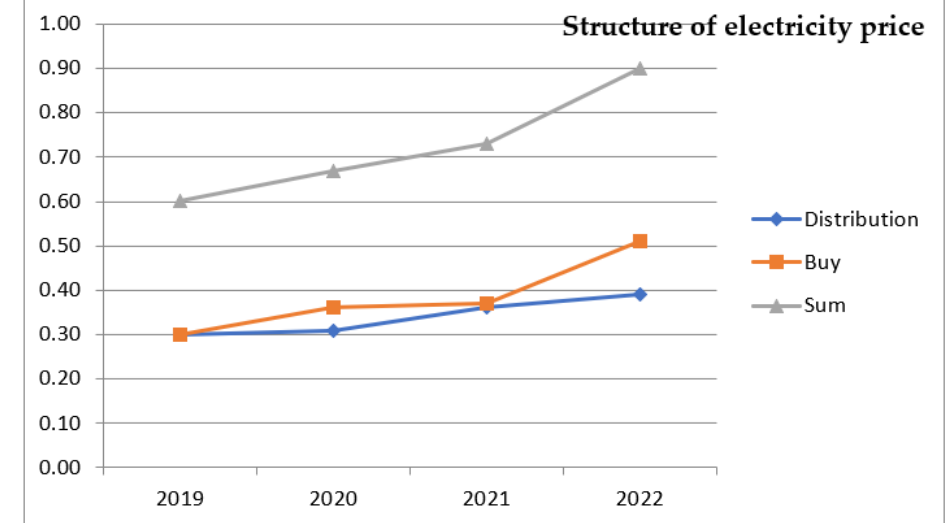
Figure 2. Analysis of the burden structure of electricity price increases in Poland in 2019 – 2022 [53].